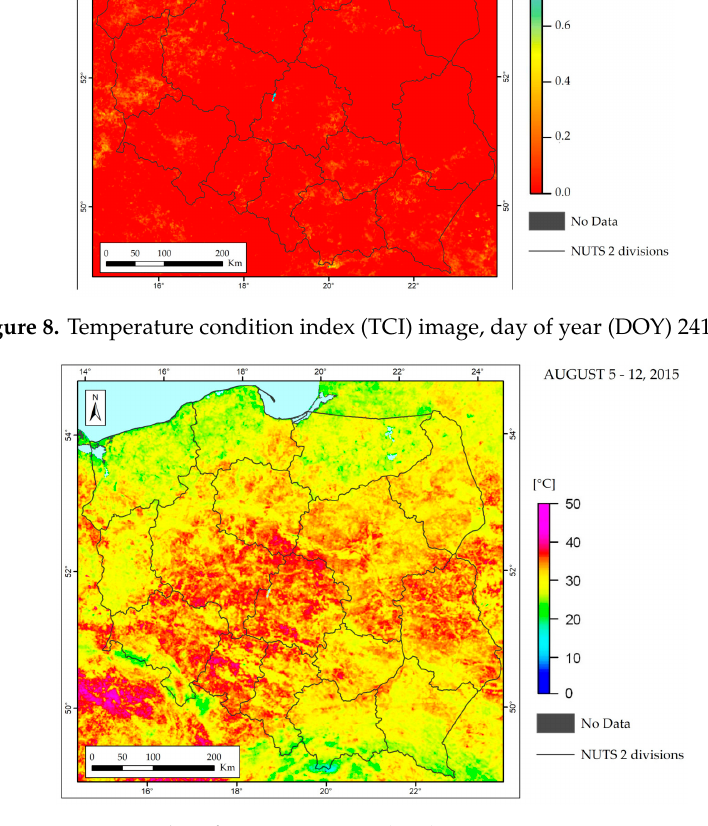
Figure 9. Land surface temperature (LST) maximum image, DOY 241.